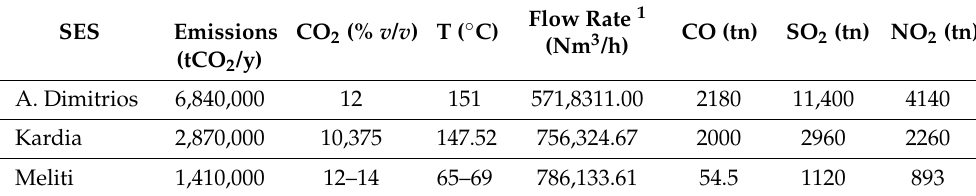
Table 4. Data on the emissions from the operational power plants of the West Macedonia in 2019.